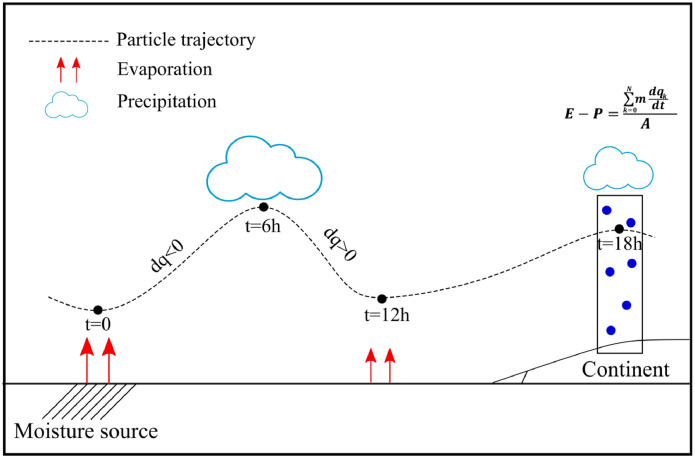
Schematic representation of moisture contribution computation.